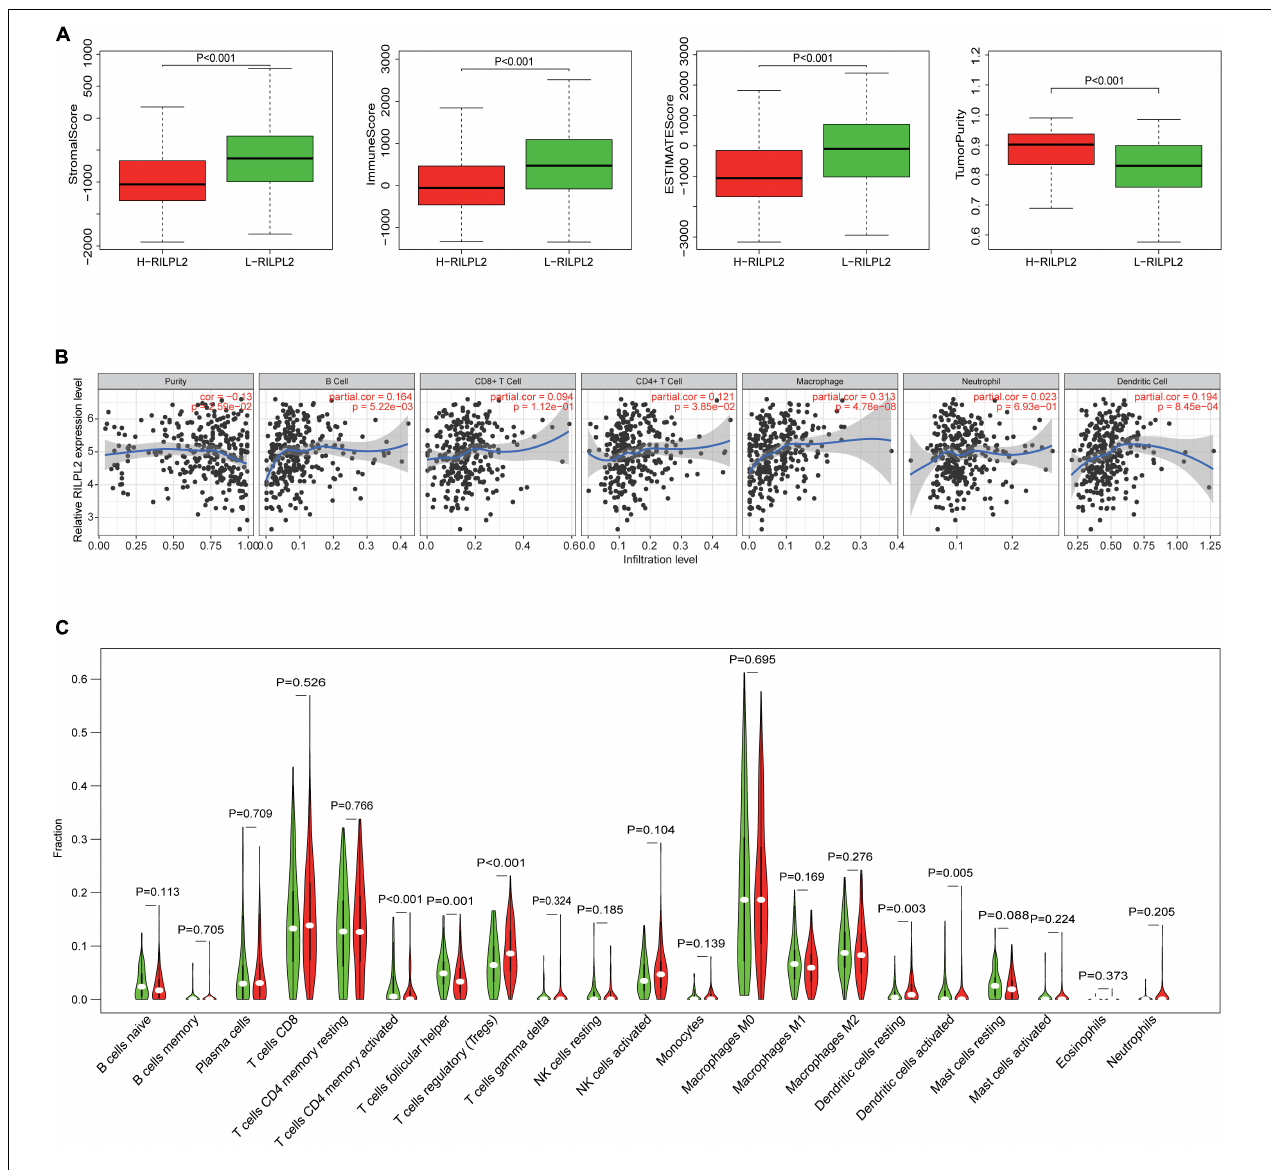
FIGURE 4 | The correlation of TIICs infiltration with RILPL2 expression. (A) Comparison of stromal scores, immune scores, ESTIMATE scores, and tumor purity between the L-RILPL2 and H-RILPL2 groups according to the ESTIMATE tool. (B) TIMER analysis of the correlation between the expression of RILPL2 and six immune cells in EC. (C) The proportion of 22 immune cells in EC tissues in the L-RILPL2 and H-RILPL2 groups.